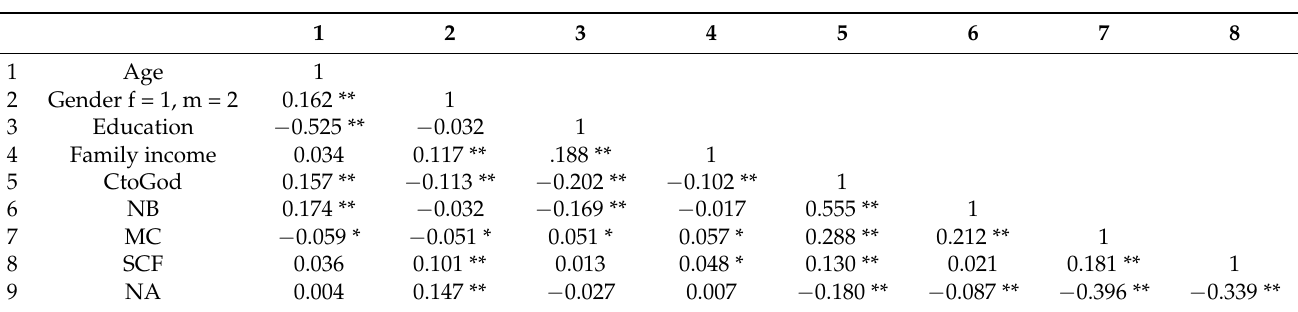
Table 2. Correlation